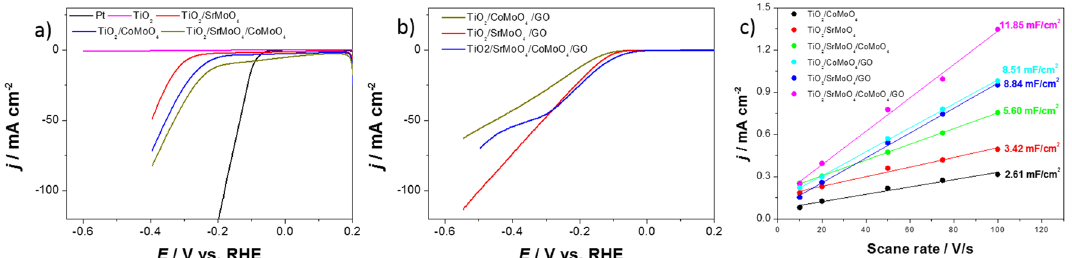
Figure 6. LSV curves of obtained catalysts ( a ) without and ( b ) with the addition of carbon. ( c ) Calculated double-layer capacitance (C DL ) used to estimate the electrochemically active surface area of the obtained catalysts.